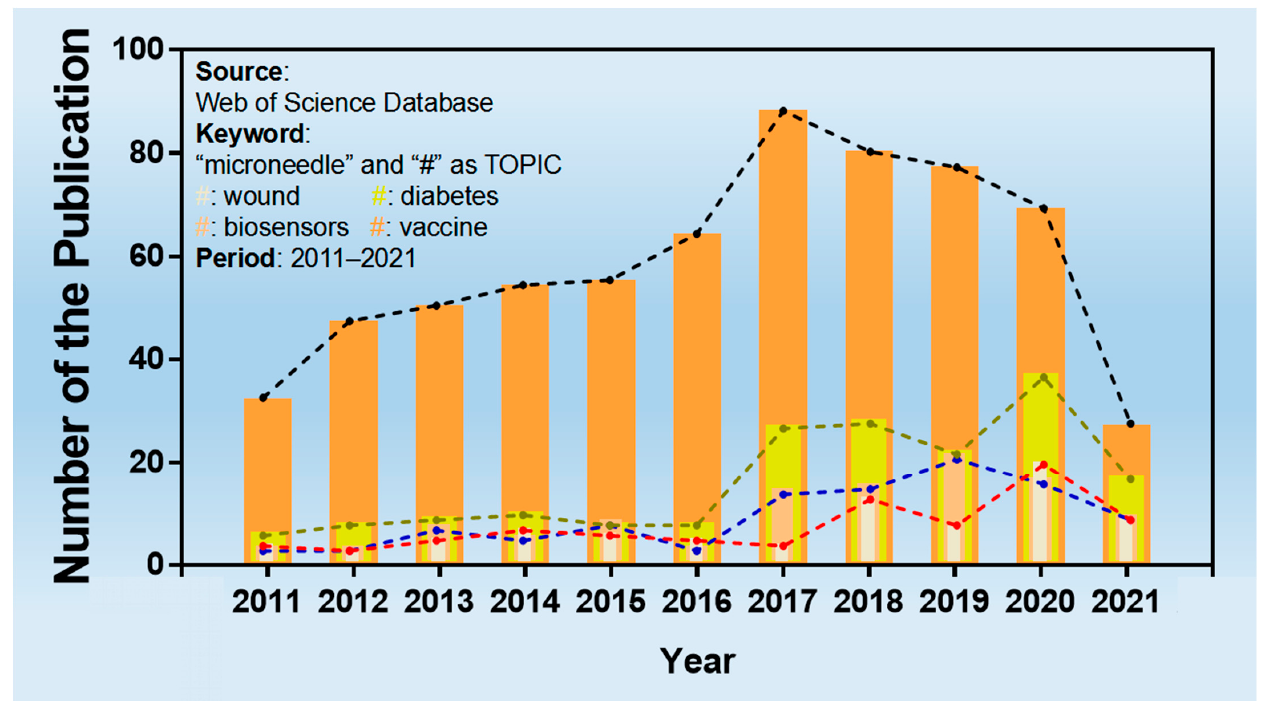
Figure 8. The number of publications on “microneedles” with different topics.